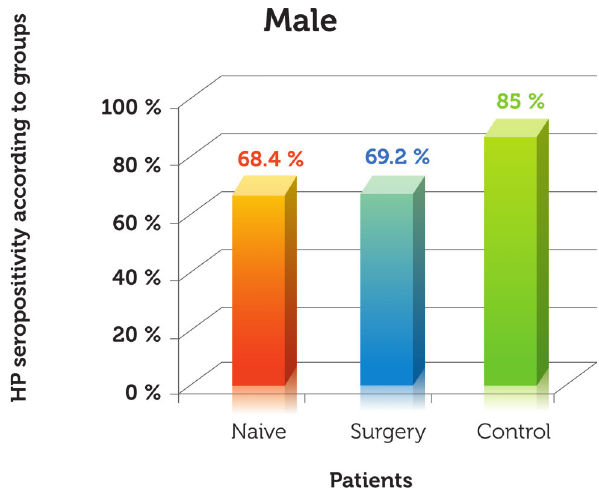
Figure 2 - Rate of HP according to